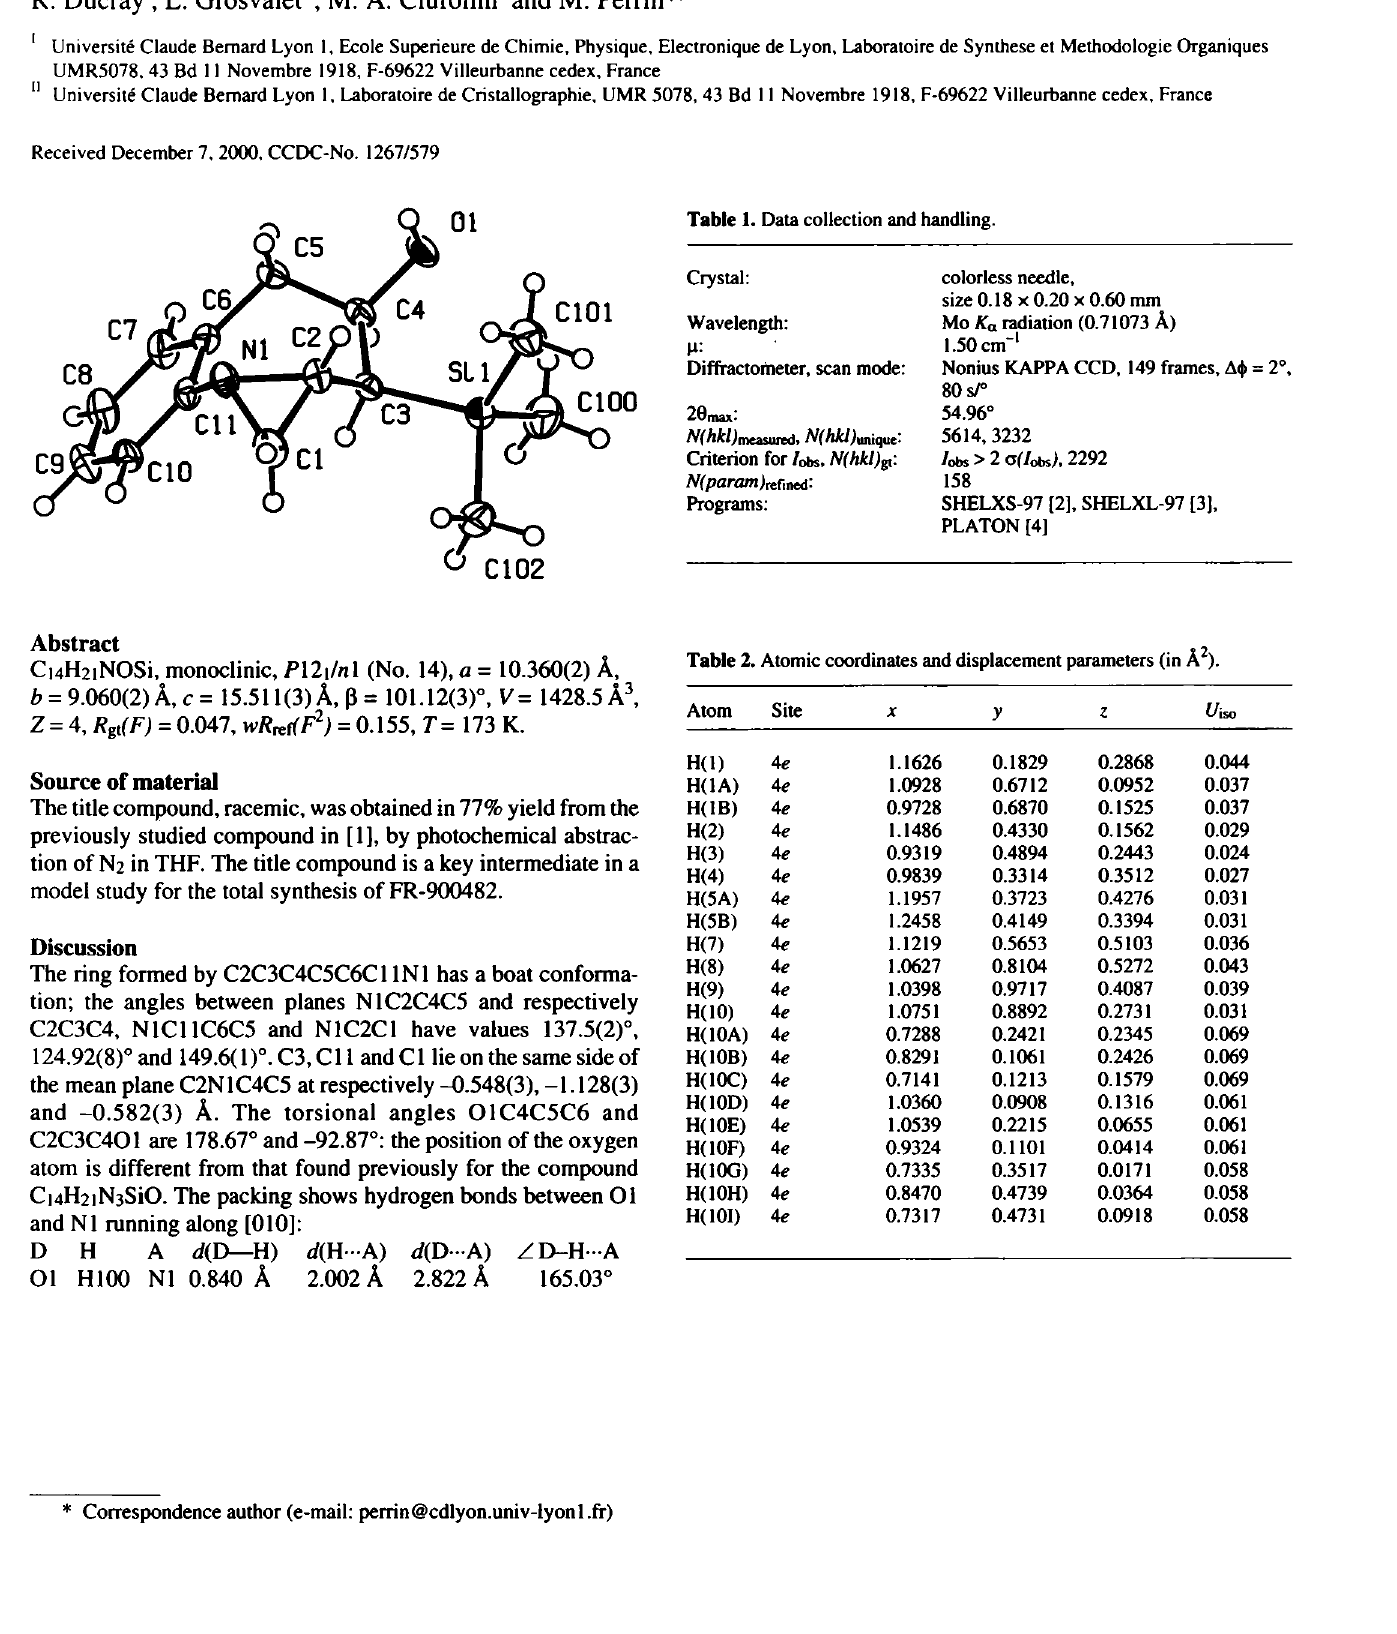
Table 1. Data collection and handling.